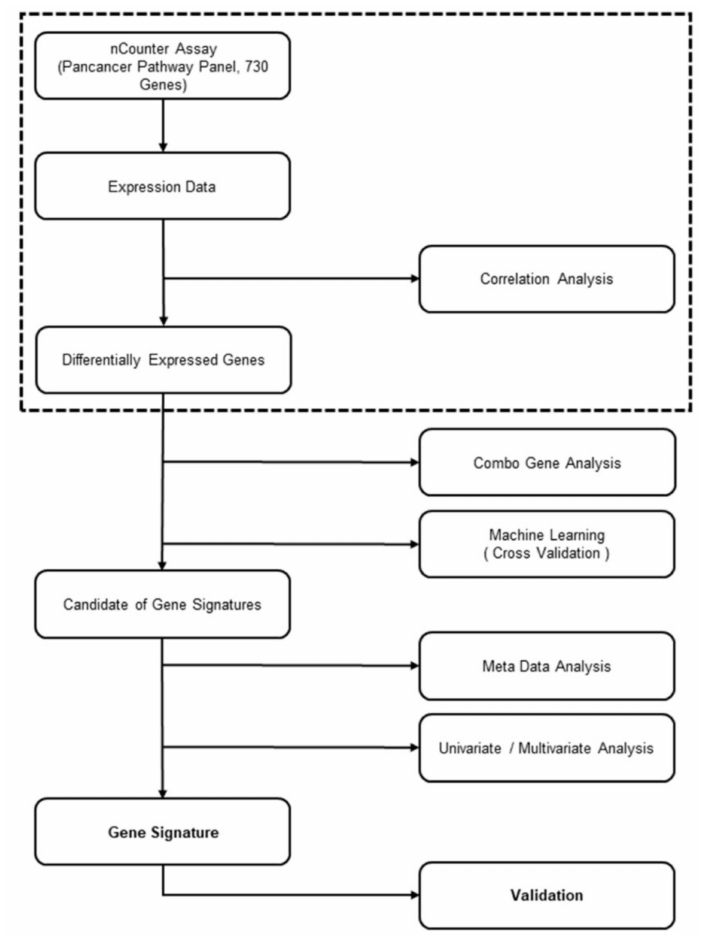
Figure 1. Gene signature development